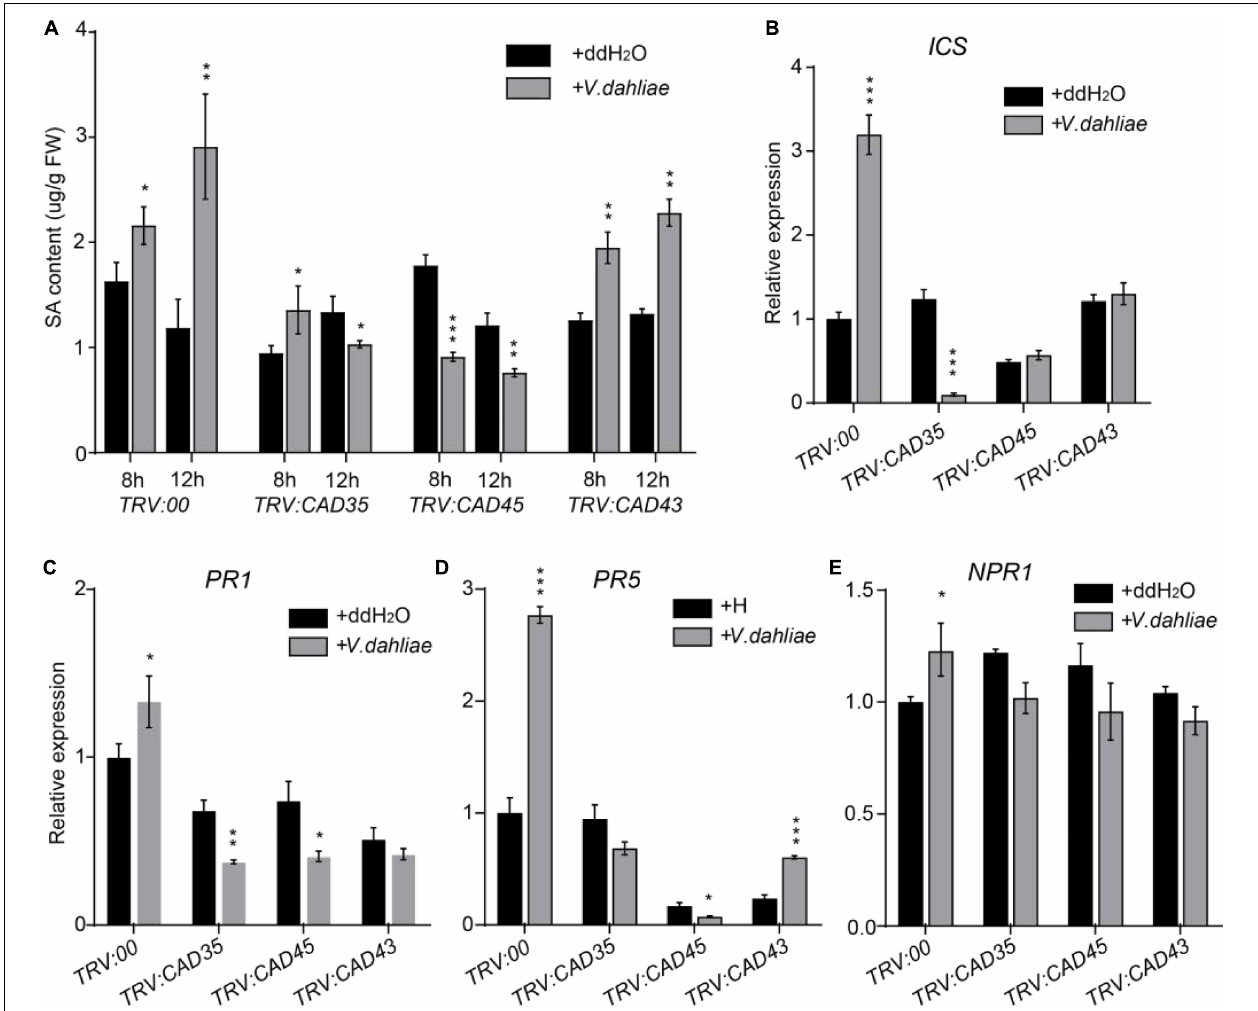
FIGURE 8 | Silencing of GhCAD35 , GhCAD45 , and GhCAD43 impaired V. dahliae induced SA responses. (A) Quantification of SA contents in TRV:00 , TRV:CAD35 , TRV:CAD45 , and TRV:CAD43 VIGS plants 8- and 12-h post-infection by V. dahliae . (B–E) The expression level of SA biosynthesis gene ICS and SA responsive genes PR1 , PR5 , and NPR1 in TRV:00 , TRV:CAD35 , TRV:CAD45 , and TRV:CAD43 VIGS plants 12-h post-infection by V. dahliae . The data represent the mean ± SD ( n = 3 biological replicates), * P < 0.05, ** P < 0.01, *** P < 0.001 (Student’s t